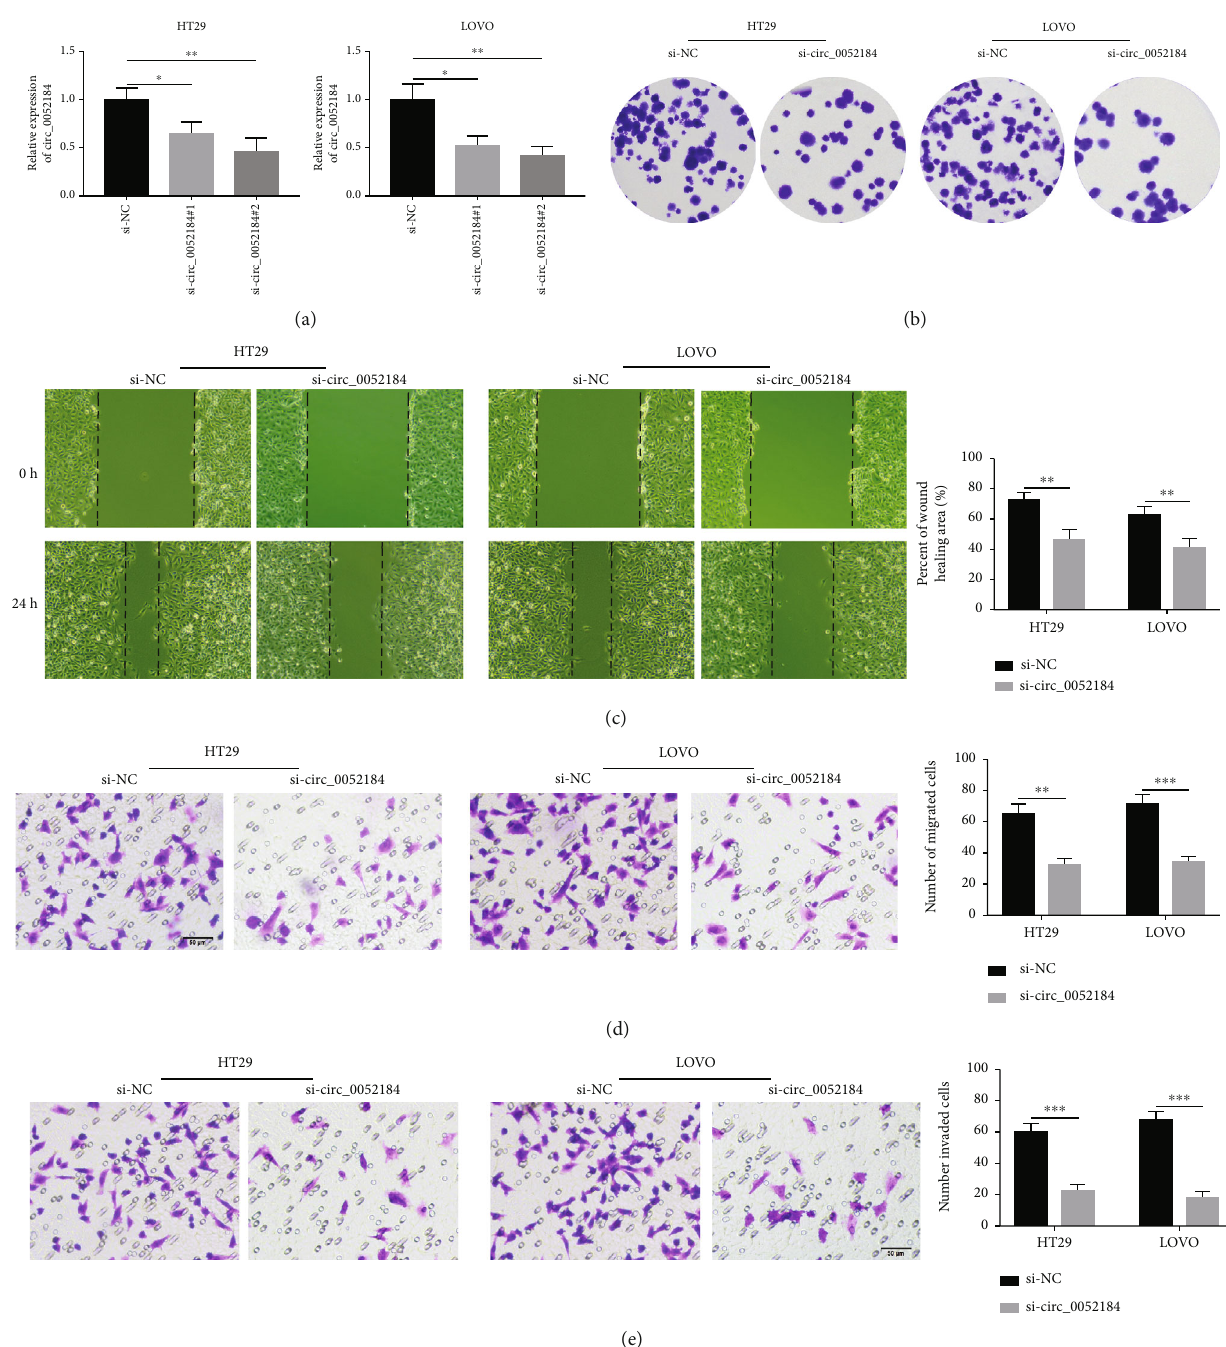
Figure 2: circ_0052184 silencing inhibited colorectal cancer cell proliferation, migration, and invasion. (a) The expression of circ_0052184 in LoVo and HT29 cells after transfection were detected by qRT-PCR. (b) Cell proliferation was detected by colony formation assay. (c, d) Cell migration was measured by wound healing assay (c) and transwell assay (d). (e) Cell invasion was detected by transwell assay. ∗ p < 0 : 05 , ∗∗ p < 0 : 01 , ∗∗∗ p < 0 : 001